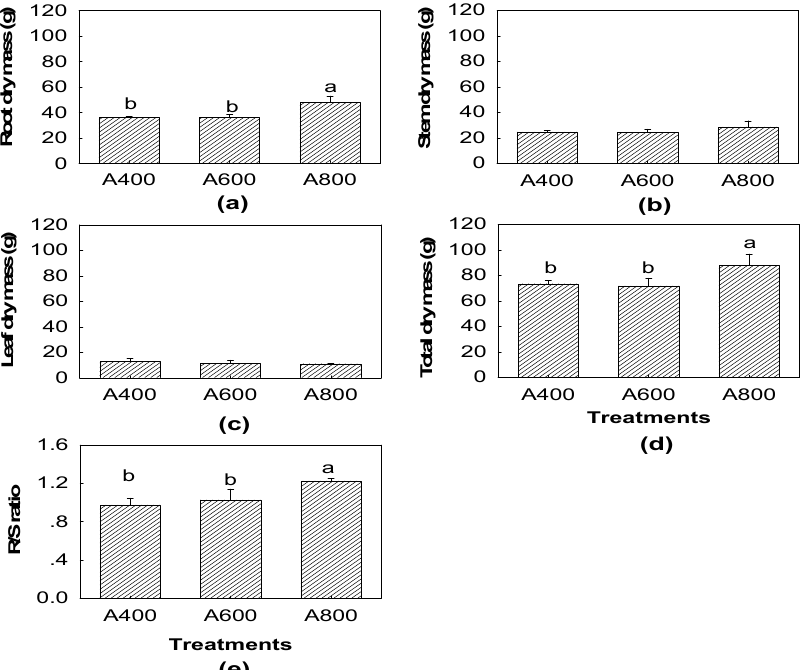
Figure 6. Dry mass of roots ( a ) stem, ( b ) leaves, ( c ) total, ( d ) mass ratio of roots to shoots (R/S ratio, and ( e ) of red maple ( Acer rubrum L.) under three CO 2 concentration treatments (A400—400, A600—600, and A800—800 µL L − 1 ). The values shown are mean ± SD. Different lowercase letters above bars mean significant multiple comparison results among CO 2 treatments when p < 0.05, n = 3.